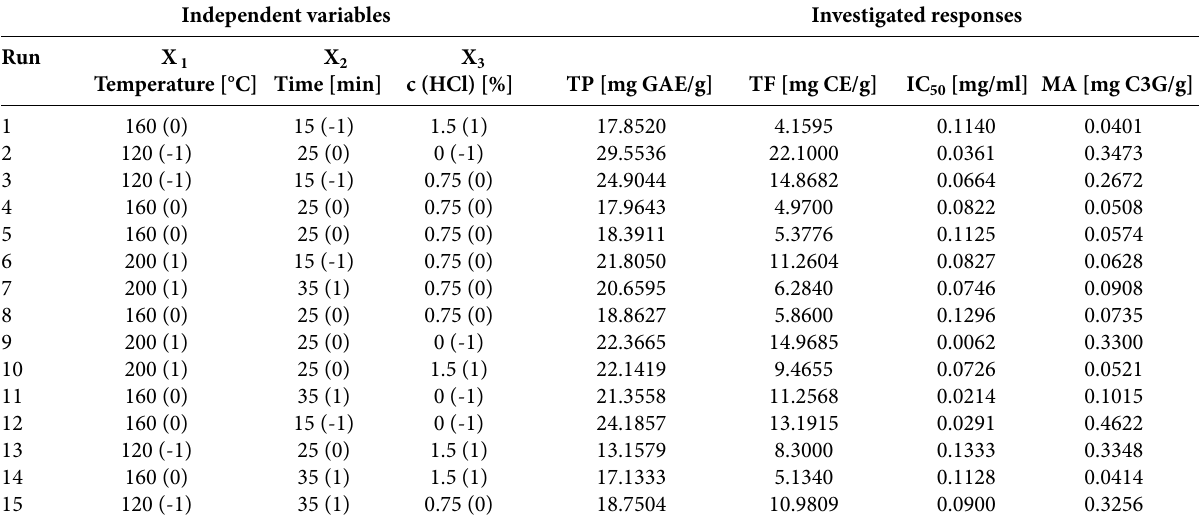
Table 2. Box-Behnken design of the three-level and three-variables and observed responses under different experimental